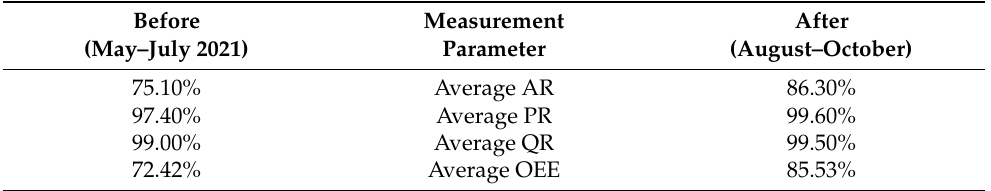
Table 10. System implementation effectiveness OEE